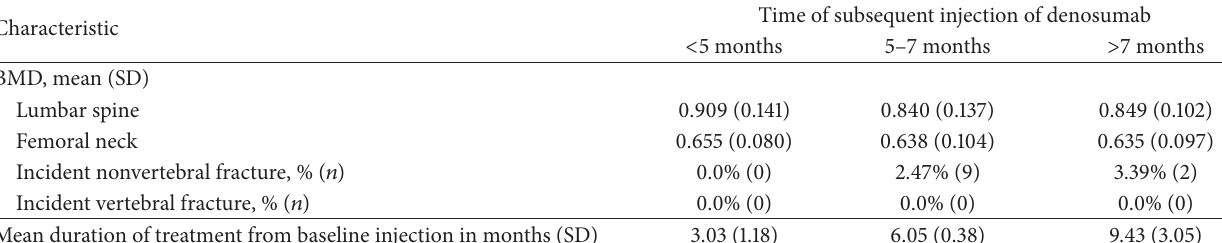
Table 2: Participant characteristics stratified by time of denosumab injection after one-year follow-up.